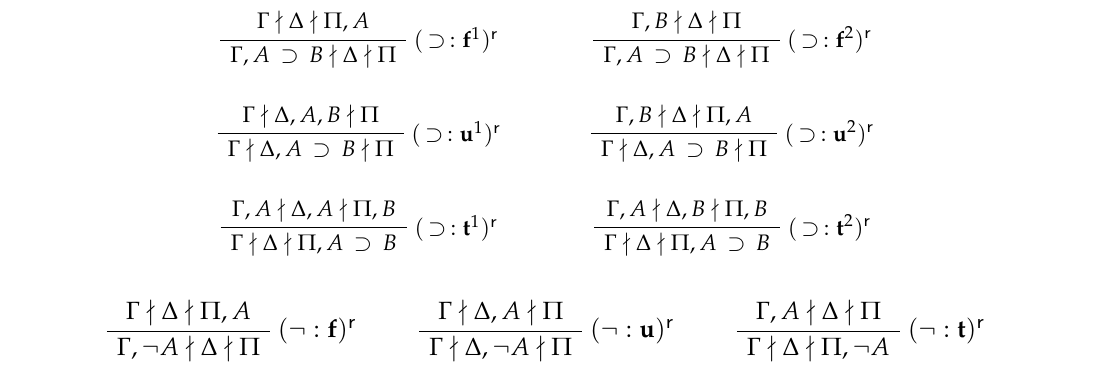
Figure 3. Rules of the anti-sequent calculus R Ł 3